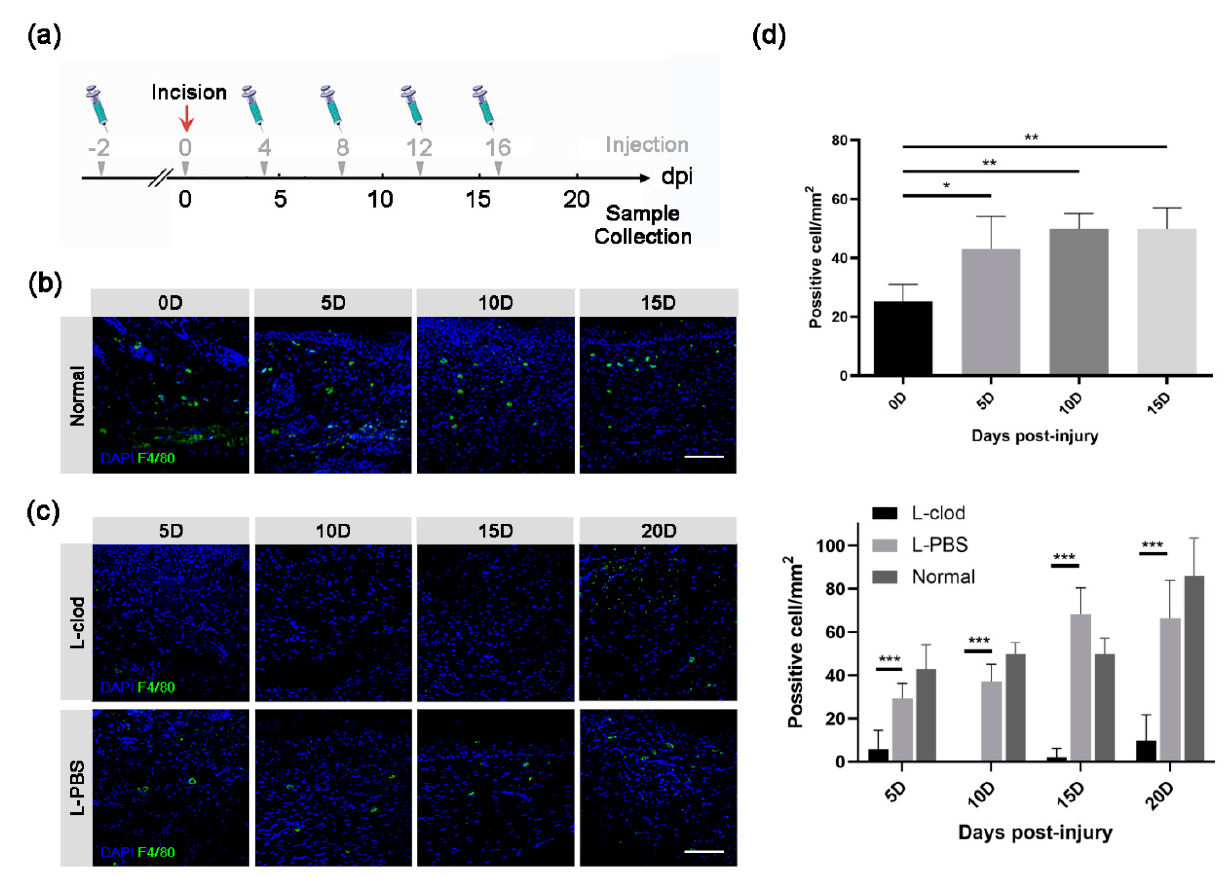
Figure 1. The distribution of macrophages during wound healing process before or after the depletion treatment. ( a ) Schematic diagram of macrophage depletion strategy. Gray arrowheads and numbers above the axis indicate L-clod or L-PBS injection time points, while black numbers below represent sample collecting days. The full-thickness skin incision was done at 0 dpi, which is represented as a red arrow. Macrophages in lesion skin tissues of either untreated ( b ) or L-clod- and L-PBS-treated ( c ) mice were detected by anti-F4/80 antibody (scale bar: 80 µm) and counted. The statistical result is presented as mean ± SD in subfigure ( d ) (upper: untreated, lower: L-clod-treated, L-PBS-treated, and untreated Normal groups. n ≥ 3. * p < 0.05, ** p < 0.01, *** p < 0.001).